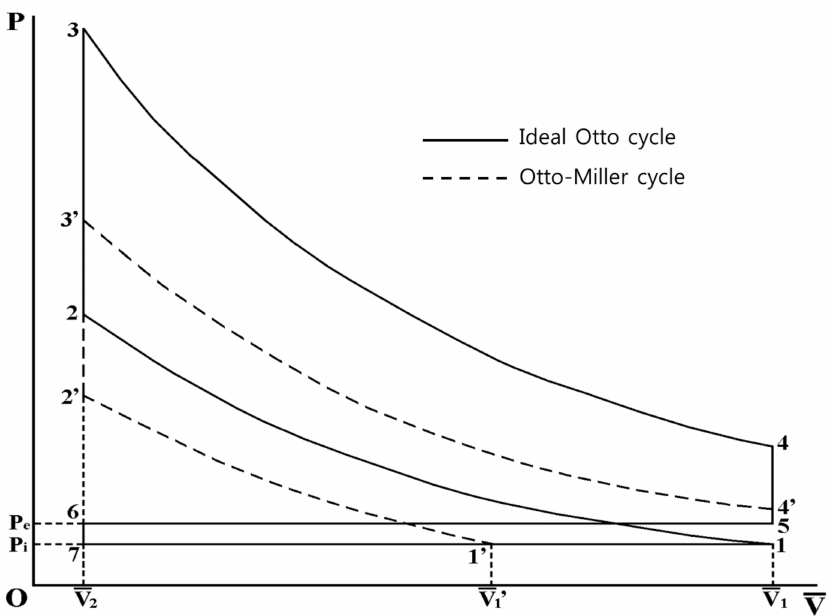
Figure 1. Curves of the ideal Otto and Otto–Miller